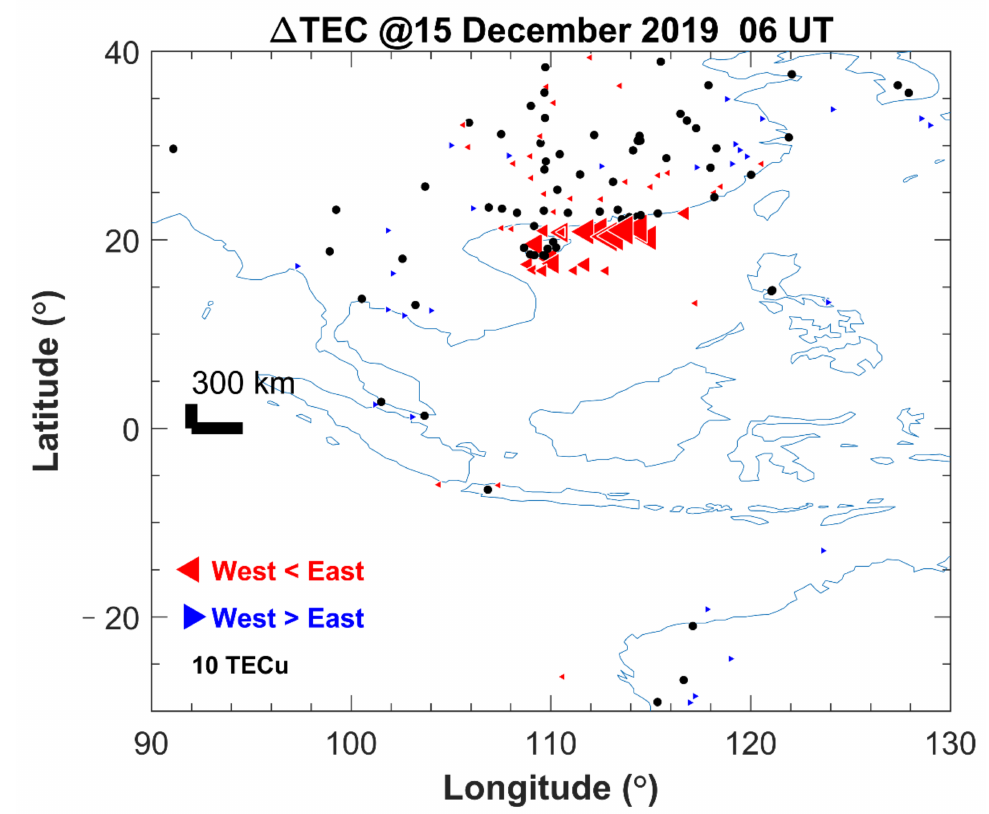
Figure 3. Distribution of the network-based ∆ TEC strength at 06 UT on 15 December (DOY 349) in 2019. Red (blue) triangles denote higher TEC on the east (west) side. The black points mark the locations of GNSS receivers. The solid horizontal and vertical bars around the equator are scales measuring a distance of 300 km in the zonal and meridional directions, respectively. The red and blue triangles at the bottom left corner act as a scale of 10